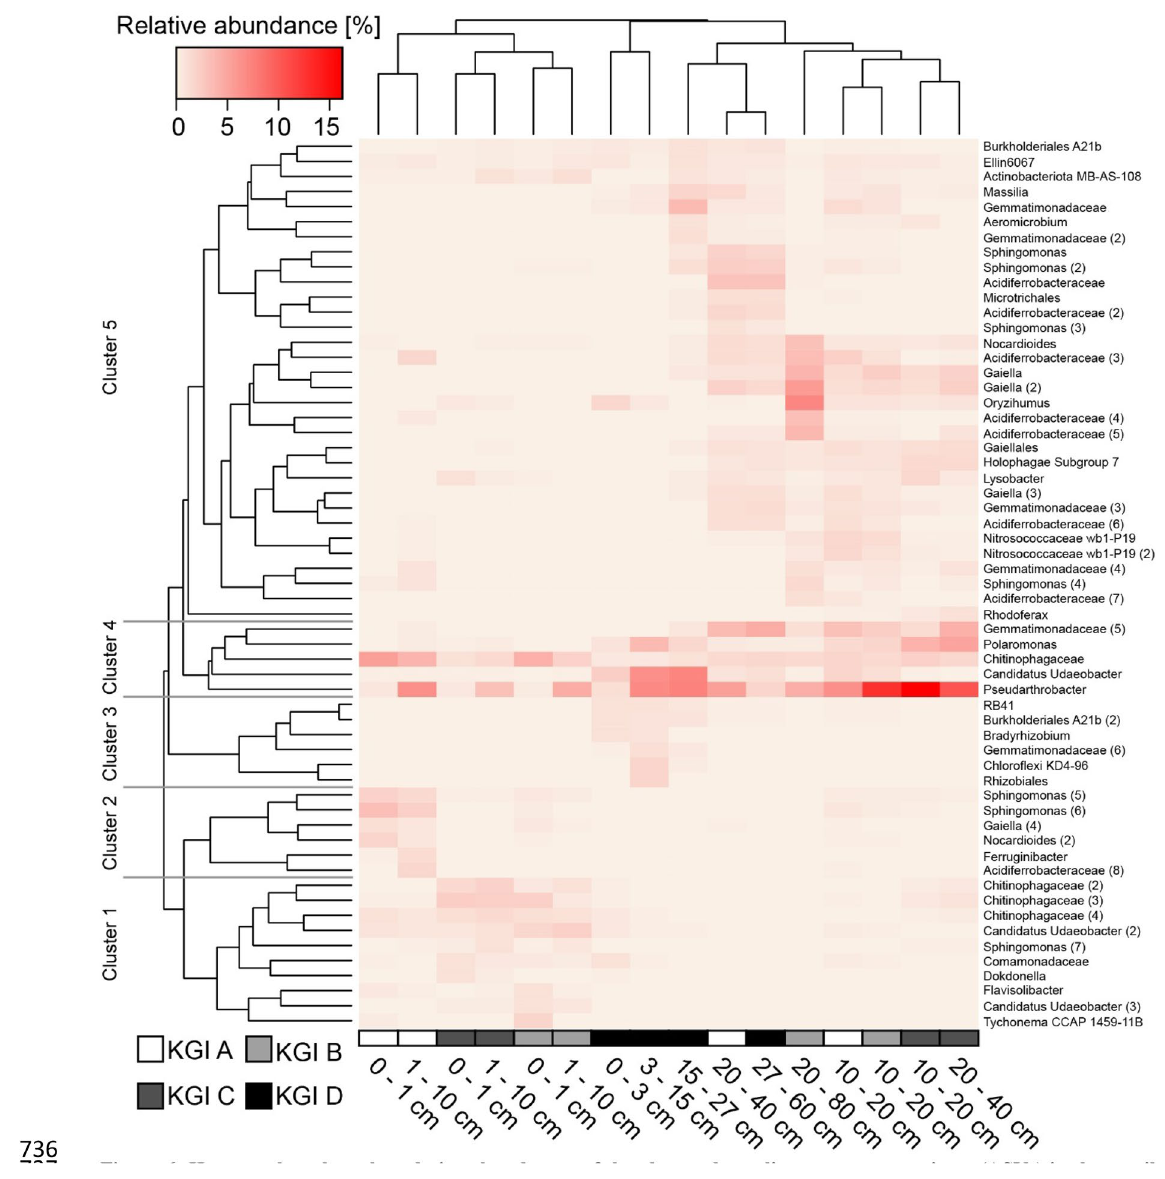
Figure 6. Heatmap based on the relative abundances of the observed amplicon sequence variants (ASVs) in three soil profiles (KGI A, KGI B, KGI C) in the recently deglaciated foreland of the Ecology glacier and one soil profile distal to the lateral moraine (KGI D) on King George Island, South Shetland Islands. Only ASVs with a relative abundance of at least 1.0% in a given sample are shown. Presented ASVs were clustered using average linkage hierarchical clustering. Samples were clustered based on the whole community using average linkage hierarchical